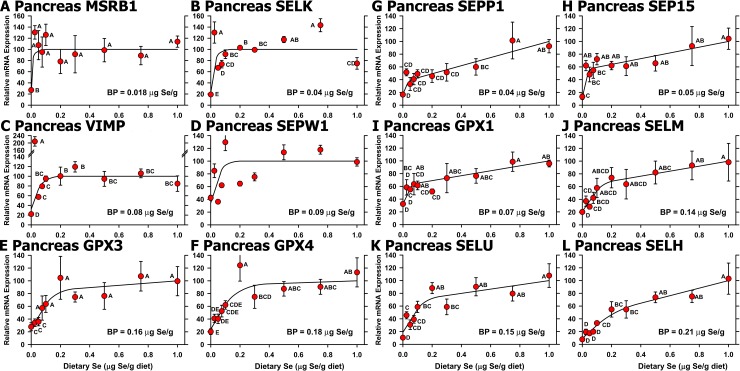
Effect of dietary Se on significantly-regulated selenoprotein transcript level in chick pancreas.Relative transcript levels are plotted for MSRB1 (A), SELK (B), VIMP (C), SEPW1 (D), GPX3 (E), GPX4 (F), SEPP1 (G), SEP15 (H), GPX1 (I), SELM (J), SELU (K), and SELH (H) in chicks supplemented with the indicated levels of dietary Se for 29 d. Values were determined in triplicate for each sample, normalized to the mean of GAPDH and ACTB levels in each sample, expressed as a percentage of Se-adequate plateau levels, and plotted as mean±SEM (n = 3-4/treatment). Means without a common letter are significantly different (P<0.05). Overall level of significance, as determined by ANOVA, is given in Table 3. Se response curve breakpoints (BP) are indicated in each panel, calculated as described in the text.